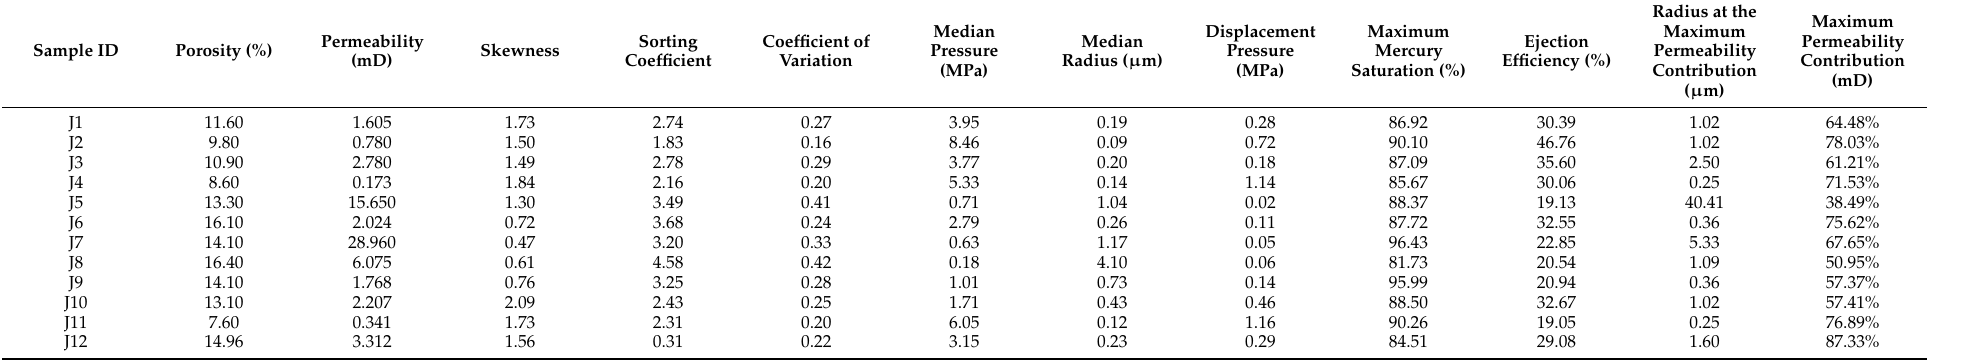
Table 3. Parameters from the HPMI